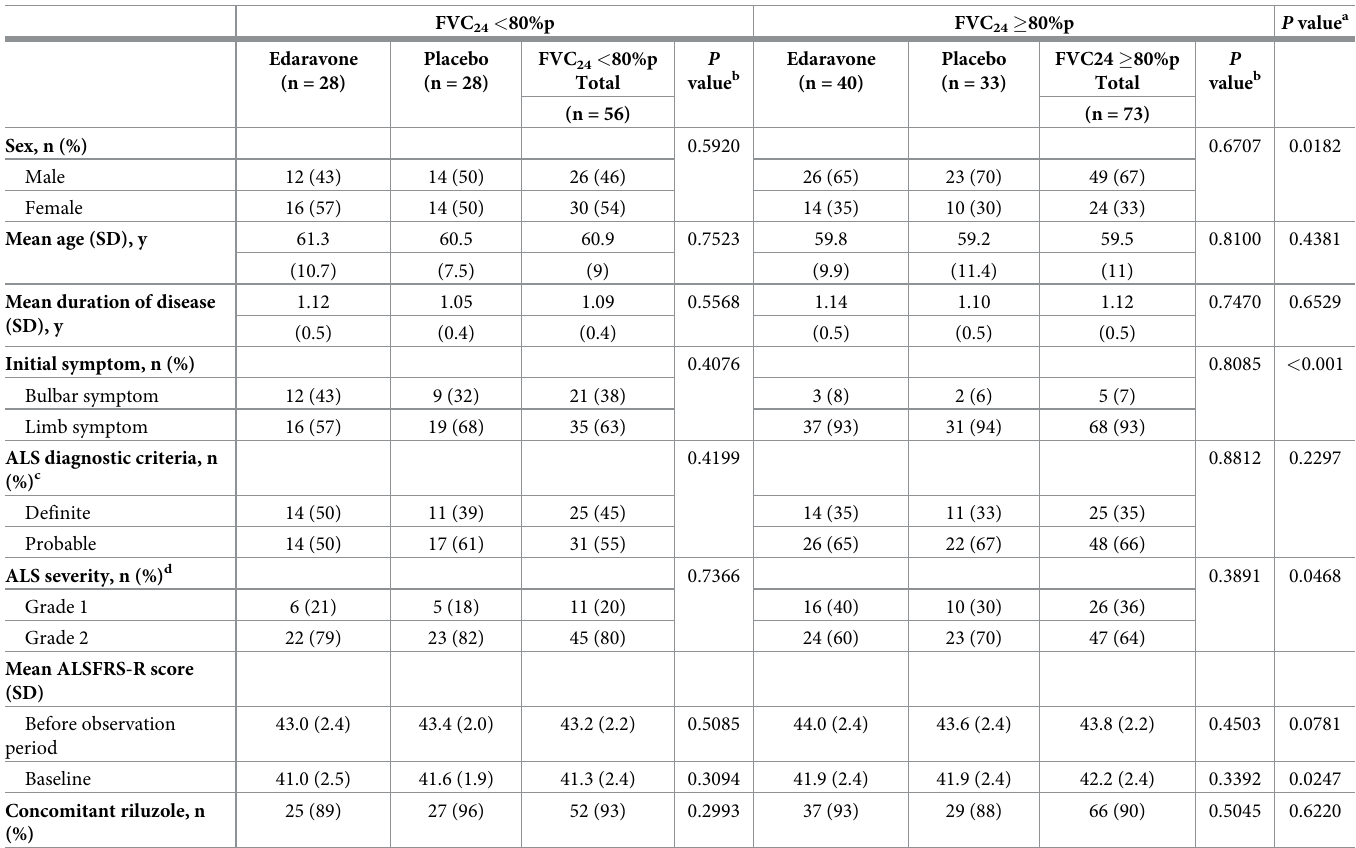
Table 2. Baseline demographics and clinical characteristics in FVC 24